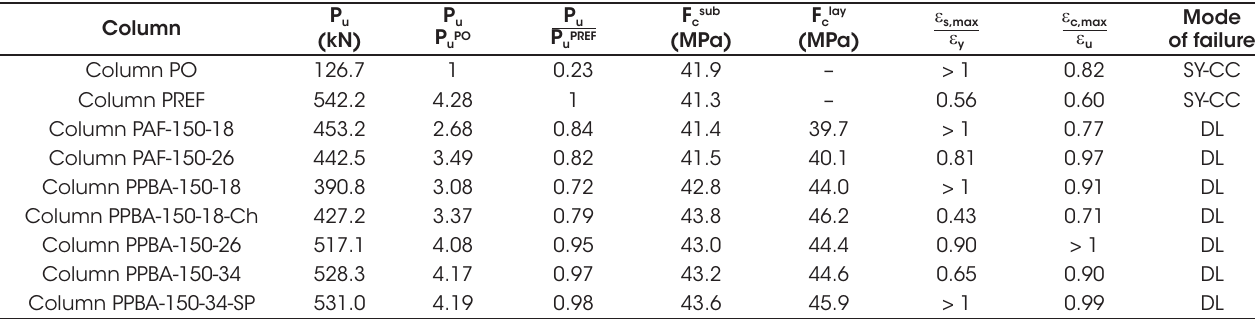
Loads and modes of